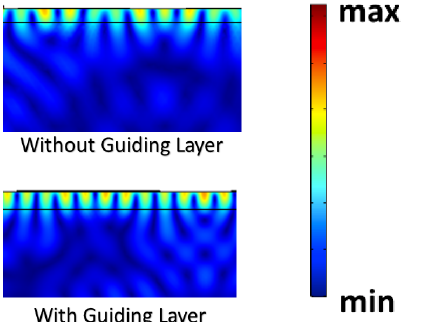
Figure 1. The top image shows a simulation of GaN on top of sapphire without a guiding layer. The bottom image is a simulation of GaN on top of sapphire with a guiding layer. The scale bar showed the higher energy to lower energy